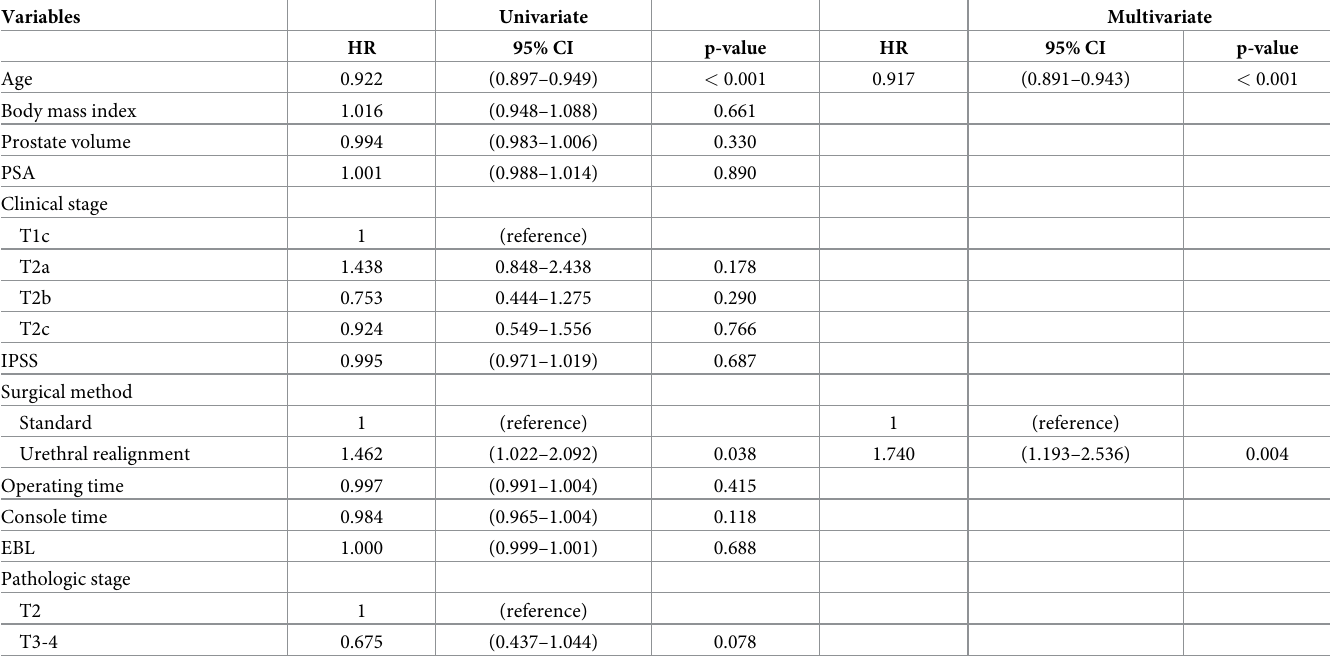
Table 4. Univariate and multivariate regression analysis of continence at 1